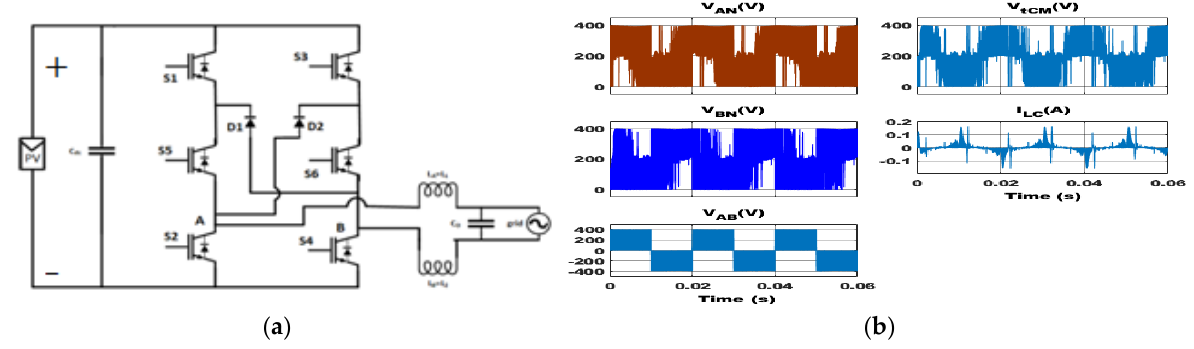
Figure 11. H6-I topology: ( a ) circuit structure; ( b ) simulation results.